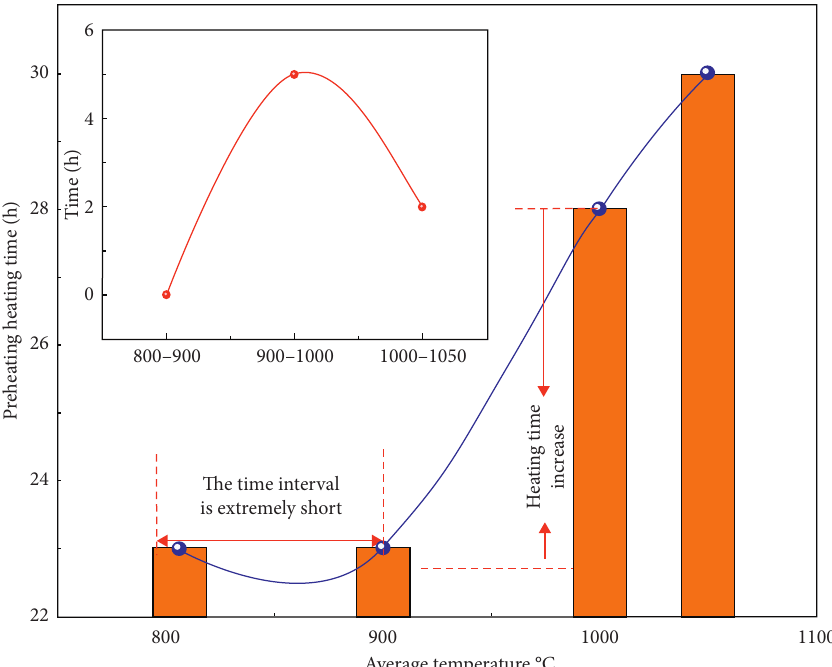
Figure 9: Relationship between average temperature and heating